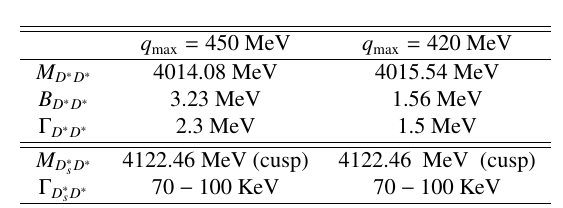
Table 1. The predictions assuming 420 or 450 MeV cuto ff values, as used for the T cc state. The D ∗ are 4017 . 1 MeV and 4122 . 46 MeV, respectively. The binding threshold masses for D ∗ D and D ∗ s energy B is referred to the closest threshold and M and Γ stand for the mass and width of the predicted states, respectively.